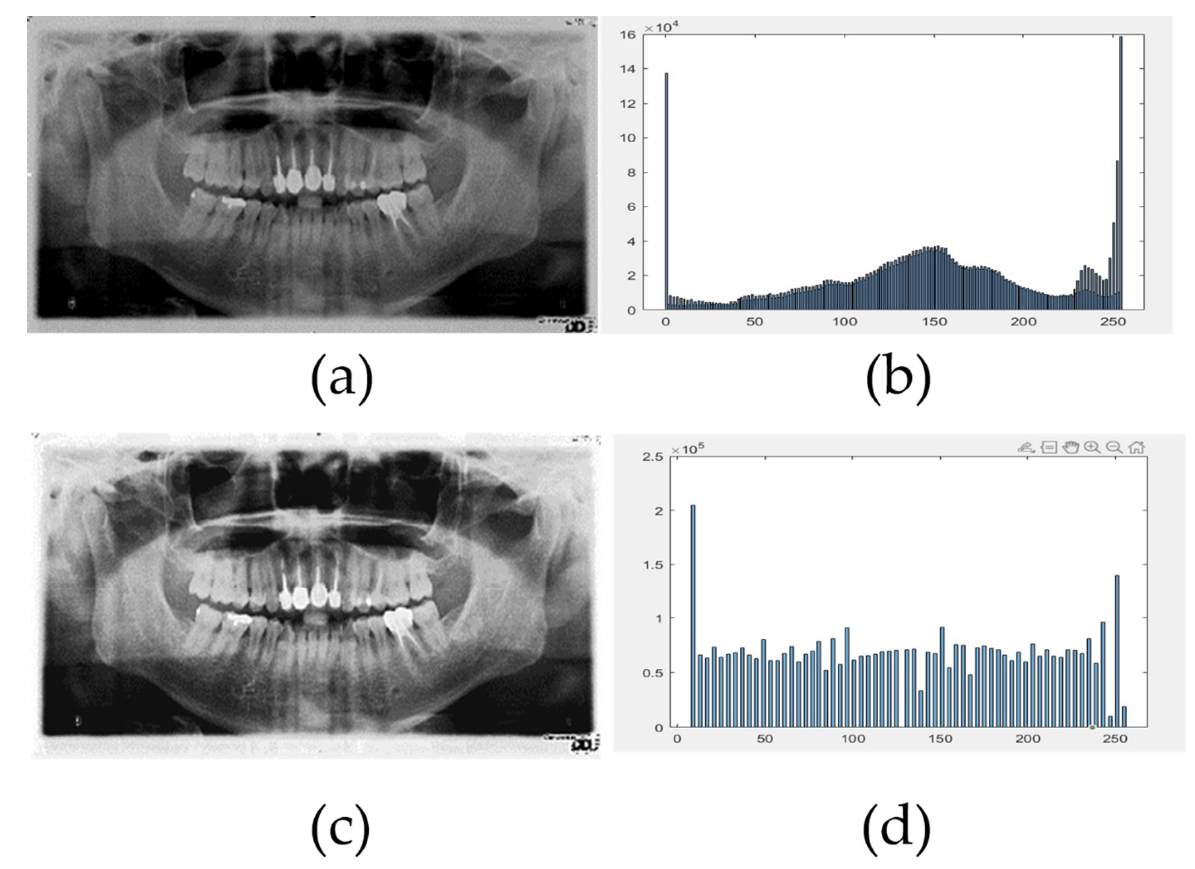
Figure 4. Adjustment of the image contrast. ( a ) Original image, ( b ) original image with the pixel value distribution, ( c ) histogram equalization processing, and ( d ) histogram equalized with the pixel value distribution.